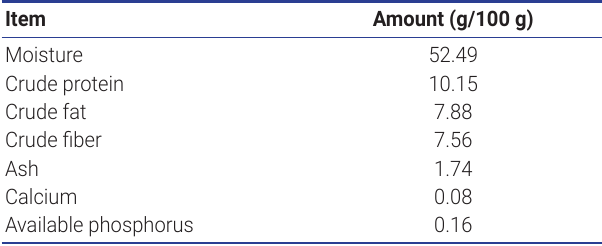
Table 1. Proximate chemical composition of the tested